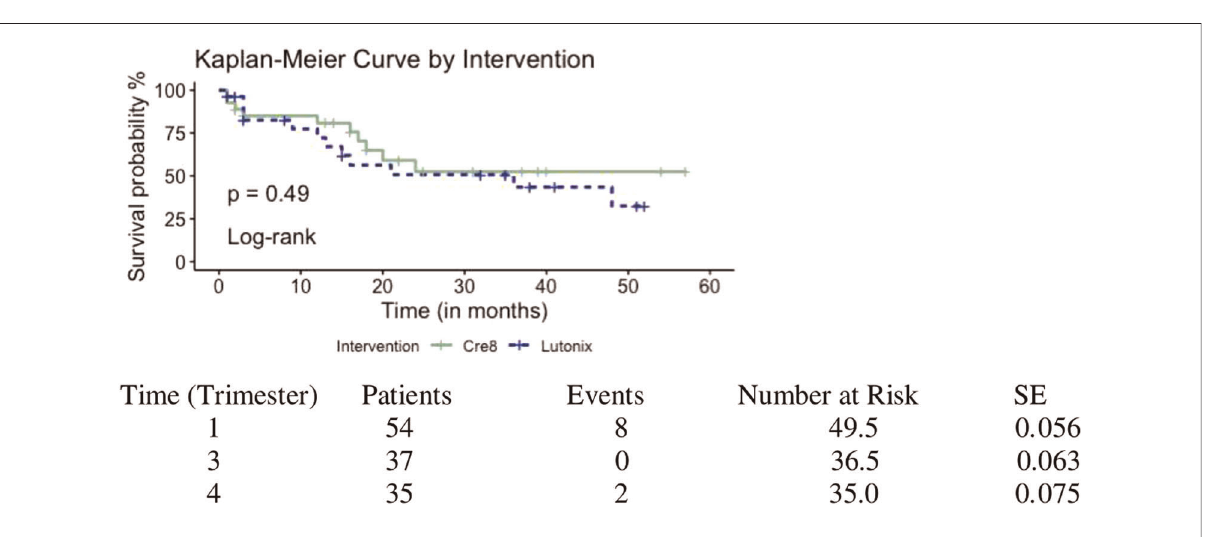
FIGURE 2 Survival rate of 2 groups using Kaplan – Meier